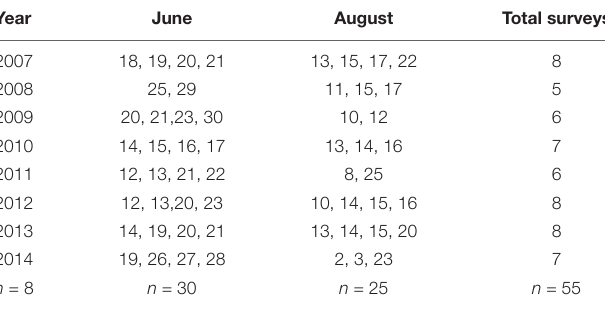
TABLE 1 | Dates of aerial photographic surveys ( n = 55) of harbor seals and ice in Johns Hopkins Inlet in Glacier Bay National Park in southeastern Alaska during the pupping period in June and during the molting period in August from 2007 through 2014.